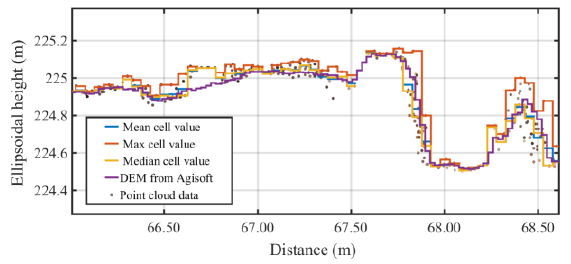
Figure 5. Rasterization of the crop surface. Cross section